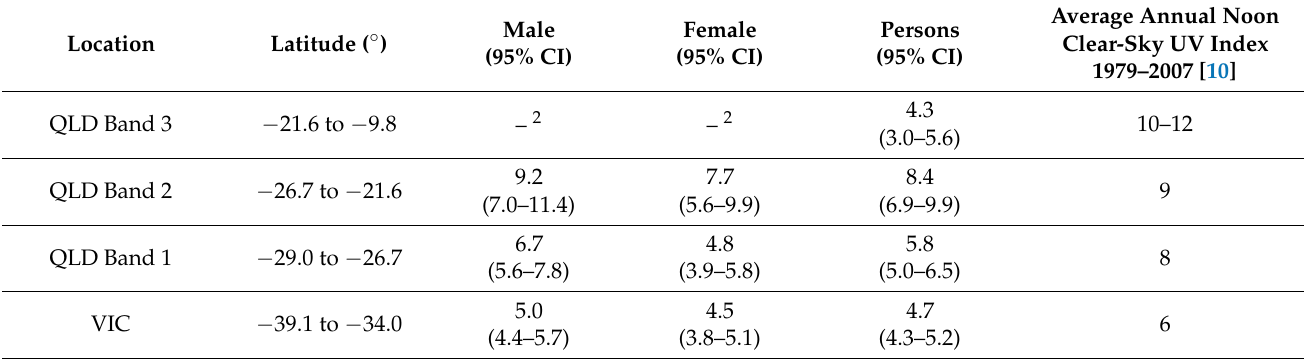
Table 3. UM ASR 1 along eastern Australia from 2001 to